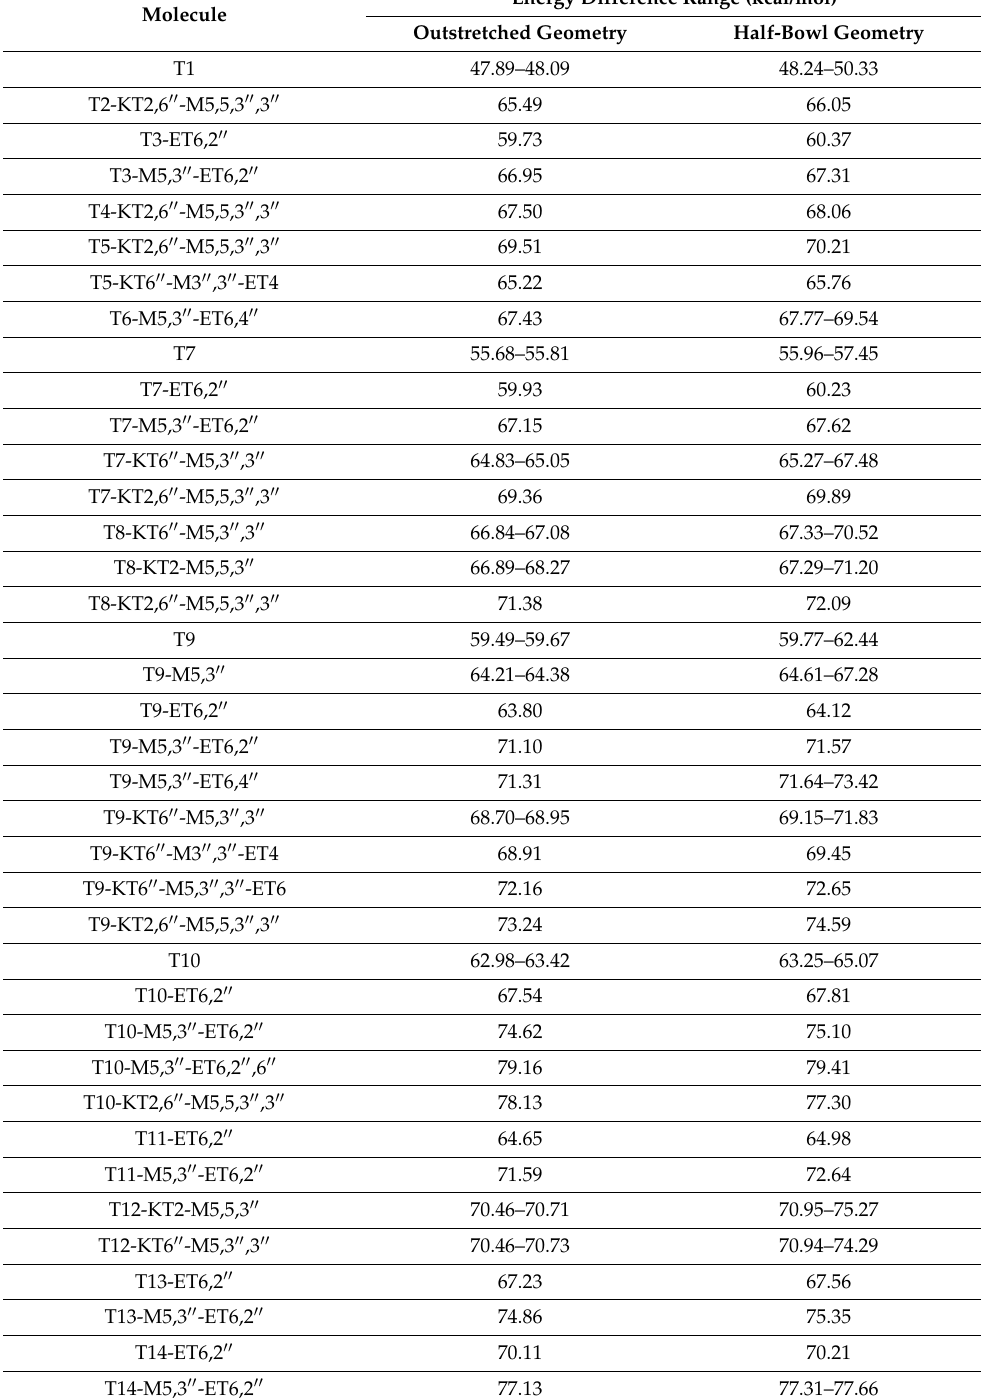
Table 3. Ranges of the lowering effect of Grimme’s correction on the estimation of the energy of the conformers of the calculated trimeric acylphloroglucinols. The lowering is evaluated as the magnitude of the difference «energy in the DFT/B3LYP/6-31+G(d,p)/D-3 result minus energy in the DFT/B3LYP/6-31+G(d,p) result». When only one conformers-pair is present for a given molecule, the value for each conformer is reported, and the two values are separated by a